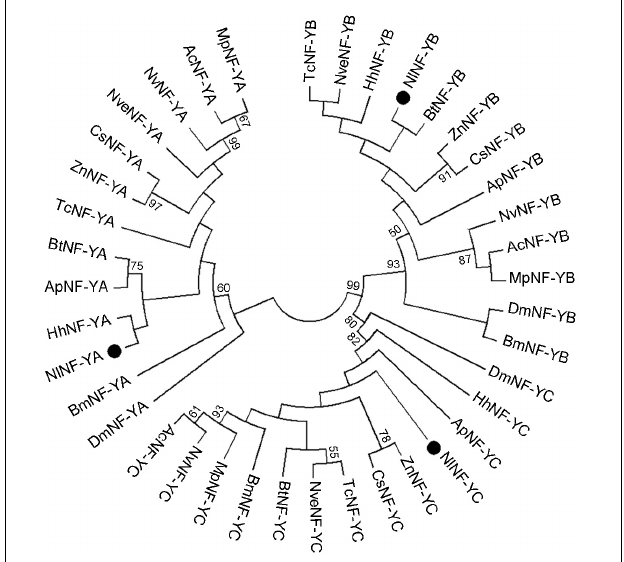
FIGURE 1 | Phylogenetic analysis of Nl NF-Y members. The phylogenetic tree was constructed with 39 full-length Nl NF-Y members from 13 species using the maximum-likelihood method and bootstrapping was set to 1,000 replications. Nl NF-YA, Nl NF-YB, and Nl NF-YC are indicated by dots. Nl, Nilaparvata lugens ; Dm, Drosophila melanogaste r; Ap, Acyrthosiphon pisum ; Ac, Apis cerana ; Bt, Bemisia tabaci ; Bm, Bombyx mori ; Cs, Cryptotermes secundus ; Hh, Halyomorpha halys ; Mp, Monomorium pharaonis ; Nv, Nasonia vitripennis ; Nve, Nicrophorus vespilloides ; Tc, Tribolium castaneum , and Zn, Zootermopsis nevadensis